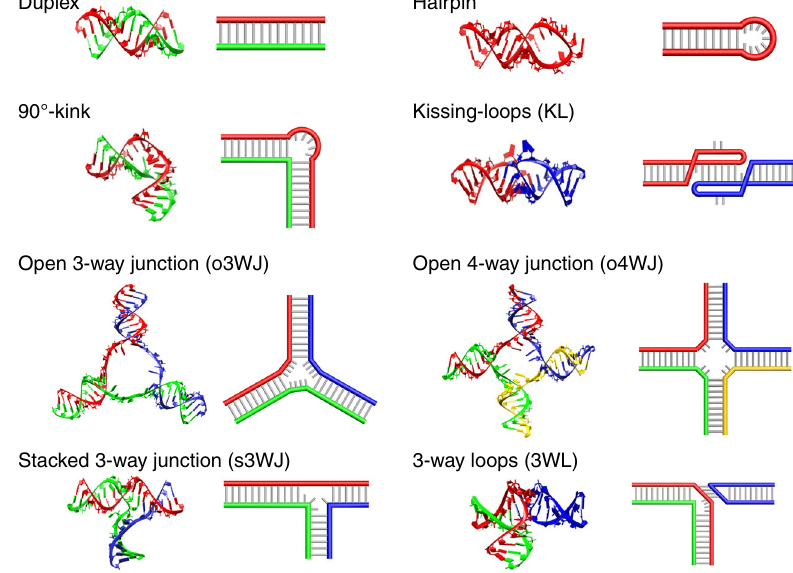
Fig. 1 Component motifs of RNA structures. For each motif, a schematic drawing and a 3D model are shown. The thick colored lines and thin gray lines represent RNA backbones and basepairs,